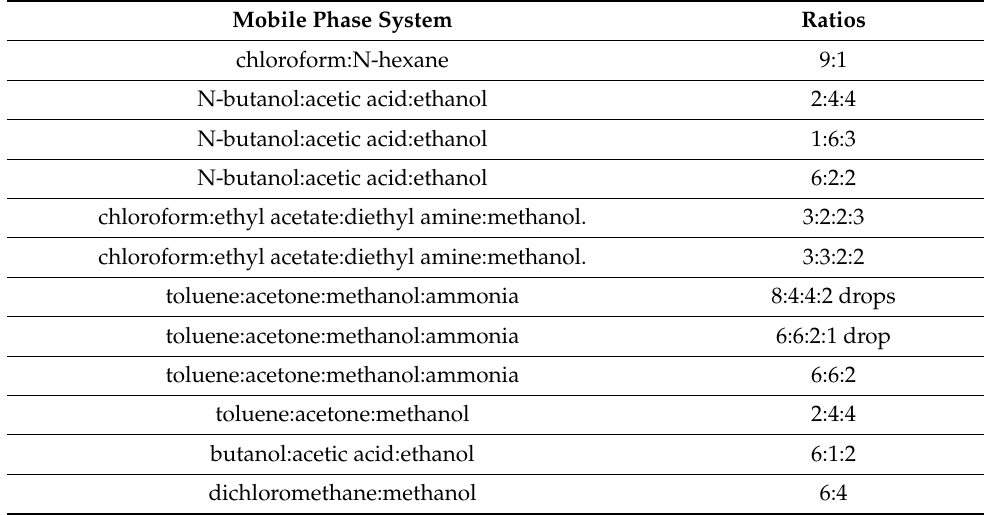
Table 1. Solvent mixtures assayed in TLC. Mobile Phase System